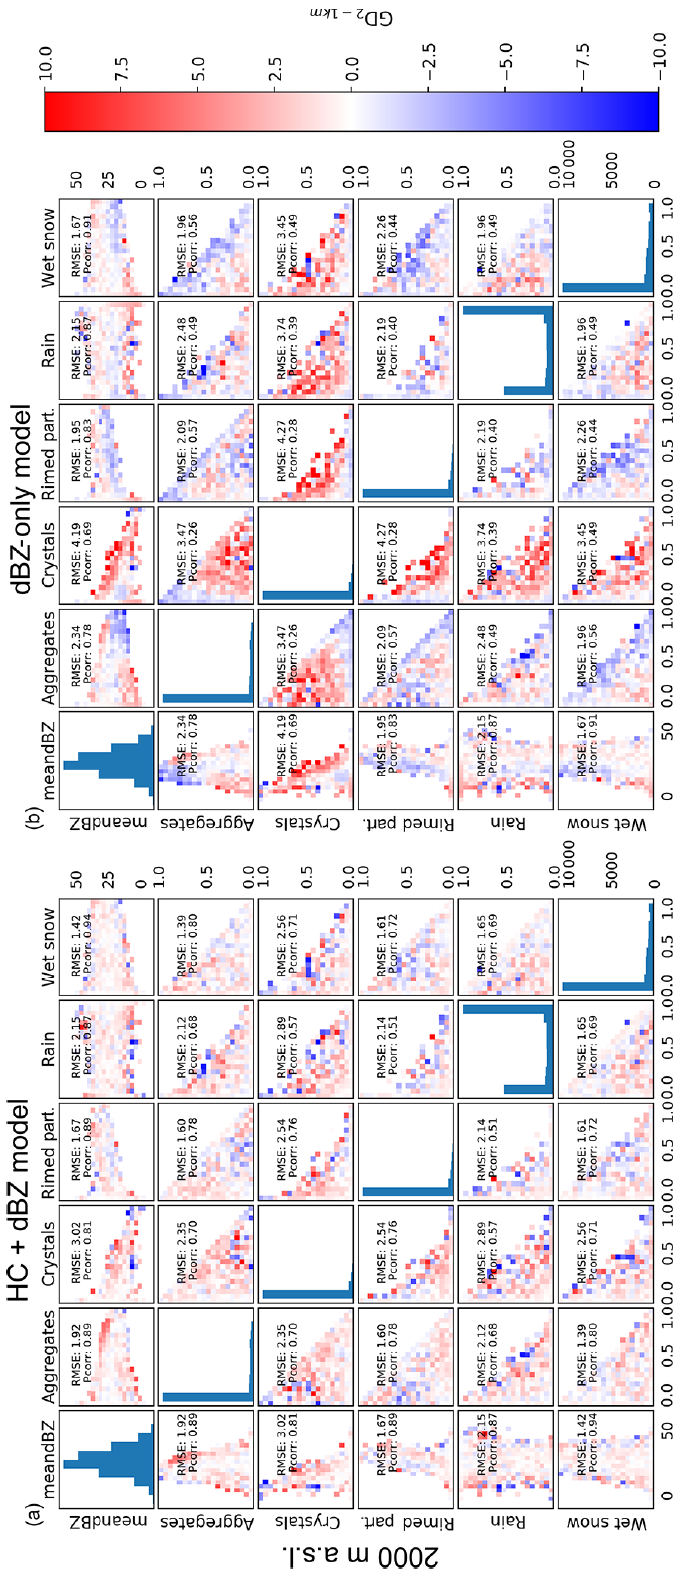
Figure 9. The 2-D error matrices from 2000ma.s.l. for the HC + dBZ model (a) and dBZ-only model (b) . The colour for each bin is based on the difference between the observed binned average and the binned average of the model